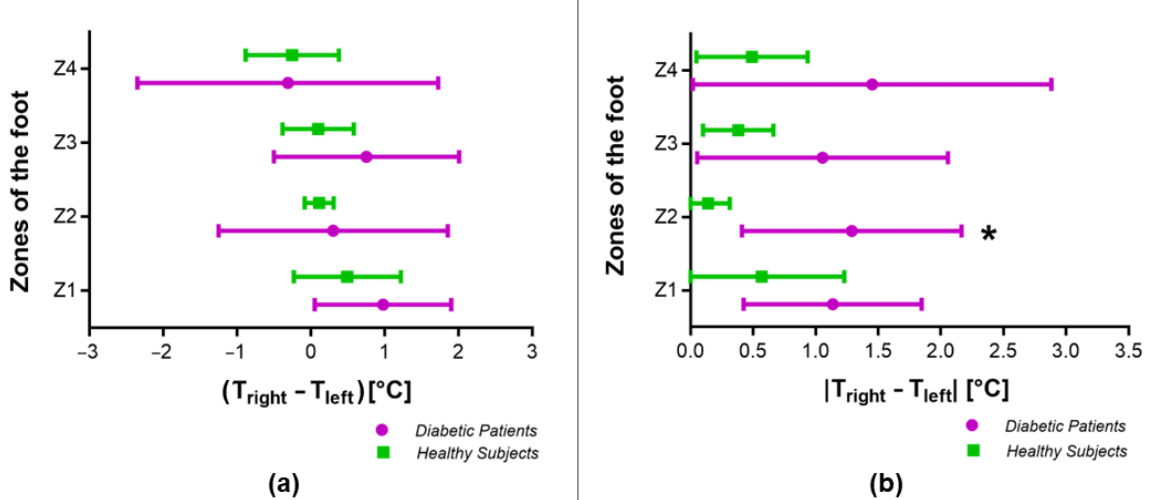
Figure 6. ( a ) Average by zone of the temperature difference of the right foot with respect to the left foot (subtraction of the temperature of the right and left feet), bars = SD. ( b ) Average by zone of the absolute difference in temperature of the right foot with respect to the left foot (absolute value of the subtraction of the temperature of the right and left feet), bars = SD, significant differences (*).